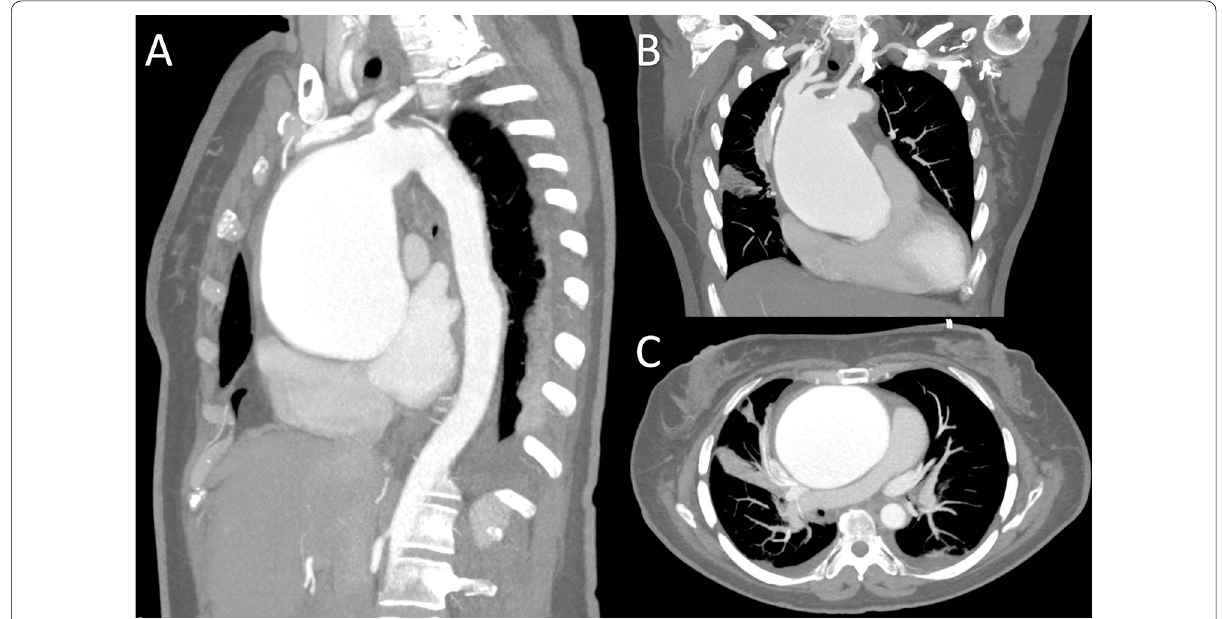
Fig. 1 A–C Angiotomography with coronal, sagittal and axial